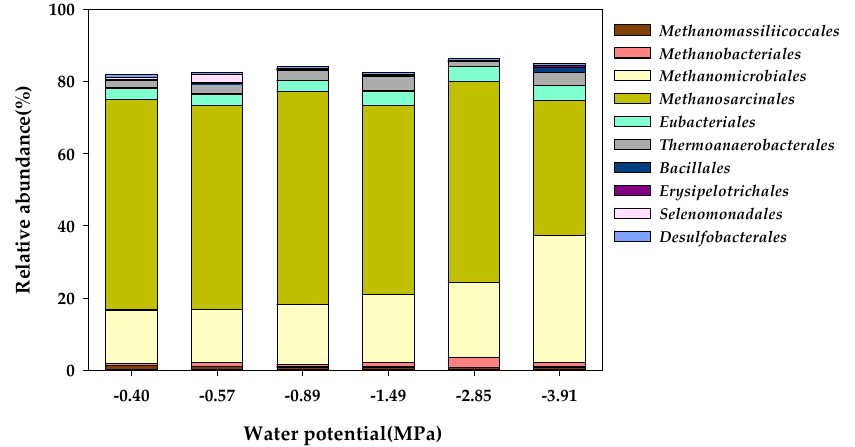
Figure 4. Order-level taxonomic classification of the microbial community in the water potential ( Ψ ) inhibition assay.